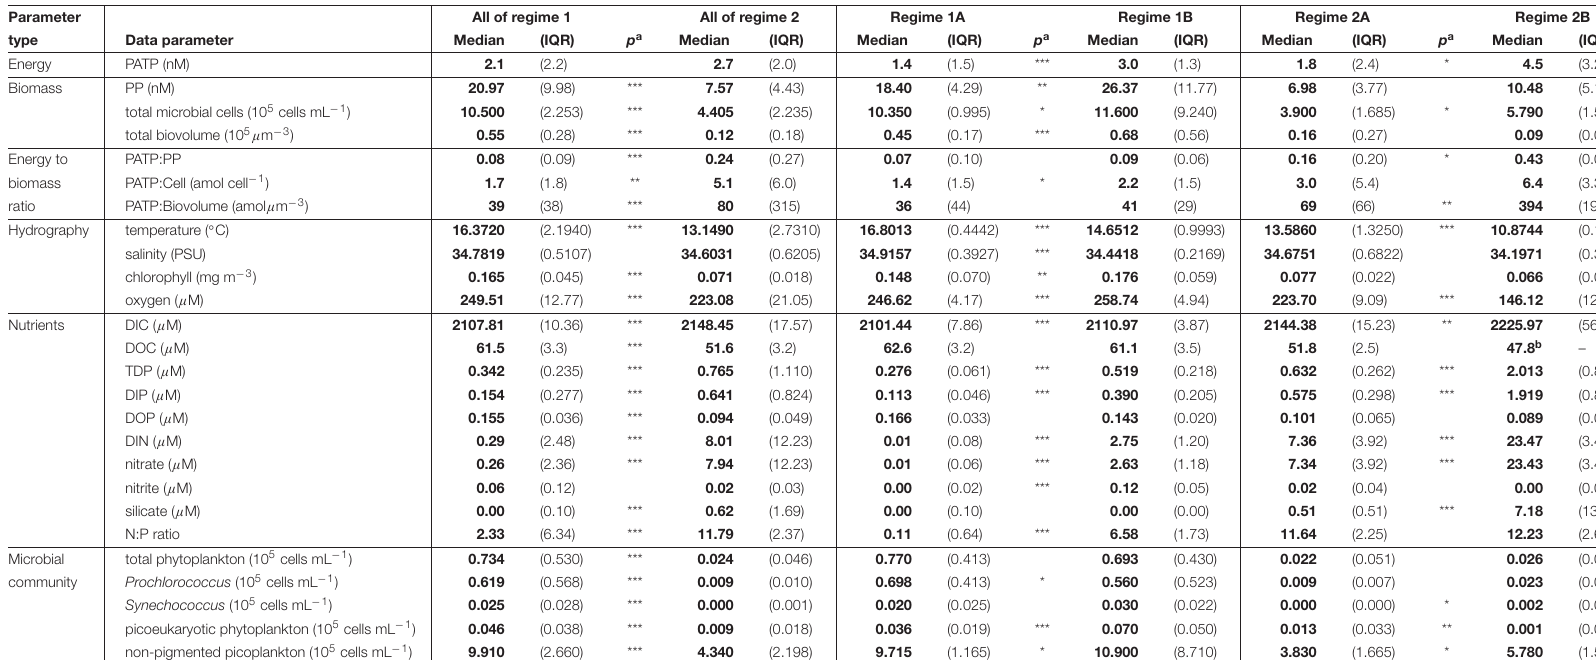
TABLE 1 | Calculated medians (bold) and interquartile ranges (IQR; parentheses) for all data parameters measured within the defined GO-SHIP P06E biogeochemical regimes and their subgroups ( Figure 4 ).